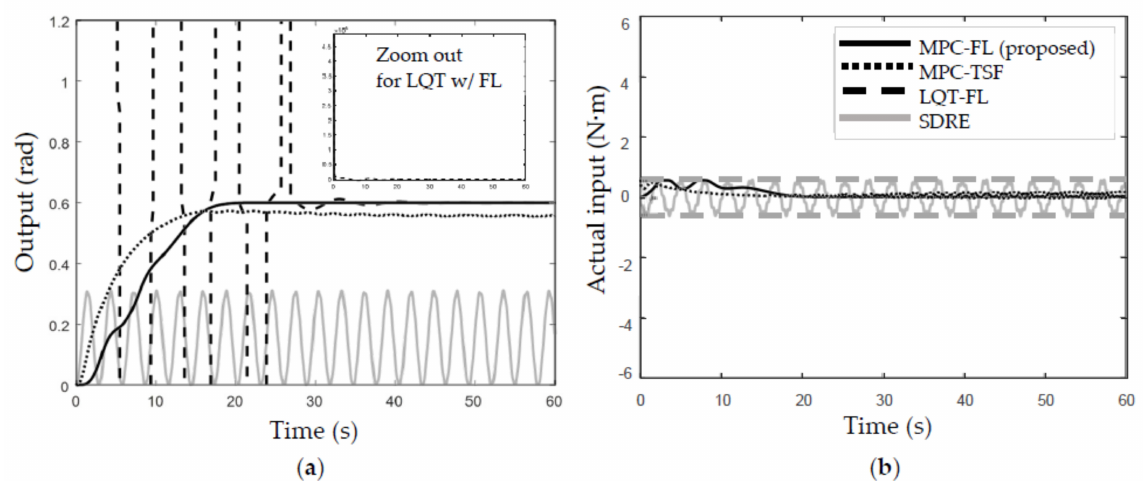
Figure 8. Flexible-joint mechanism by applying the four control schemes with input constraints ± 0.56 N · m: ( a ) output responses; ( b ) input